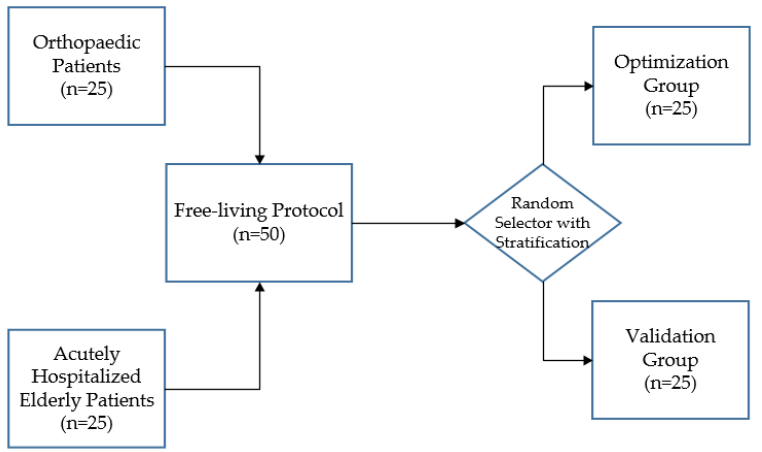
Figure 1. After stratification according to department, 50 patients were randomly assigned to the optimization or validation group.